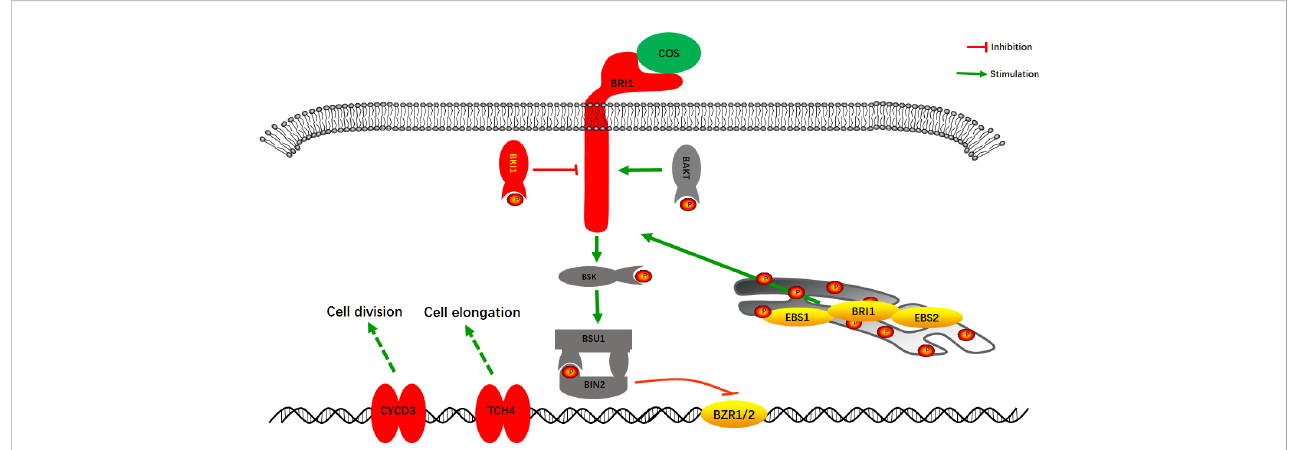
FIGURE 7 A model of the BRs cell signaling pathway in Passi fl ora spp. response to COS. Red, up-regulated expression; Yellow, down-regulated expression; P,